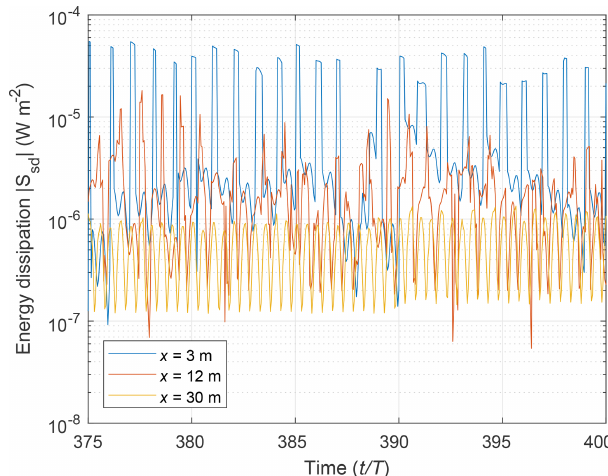
Figure 4. Time series of the modulus of the wave energy dissi- pation term | S sd | in simulations with L x = 0 . 5m, T = 1 . 2s, a 0 = 0 . 0125m, C sd = 0 . 05, ε = 0 . 6, and ML dispersion relation (see yel- low curve in Fig. 2a), for three selected floes, located at 3, 12, and 30m from the ice edge.